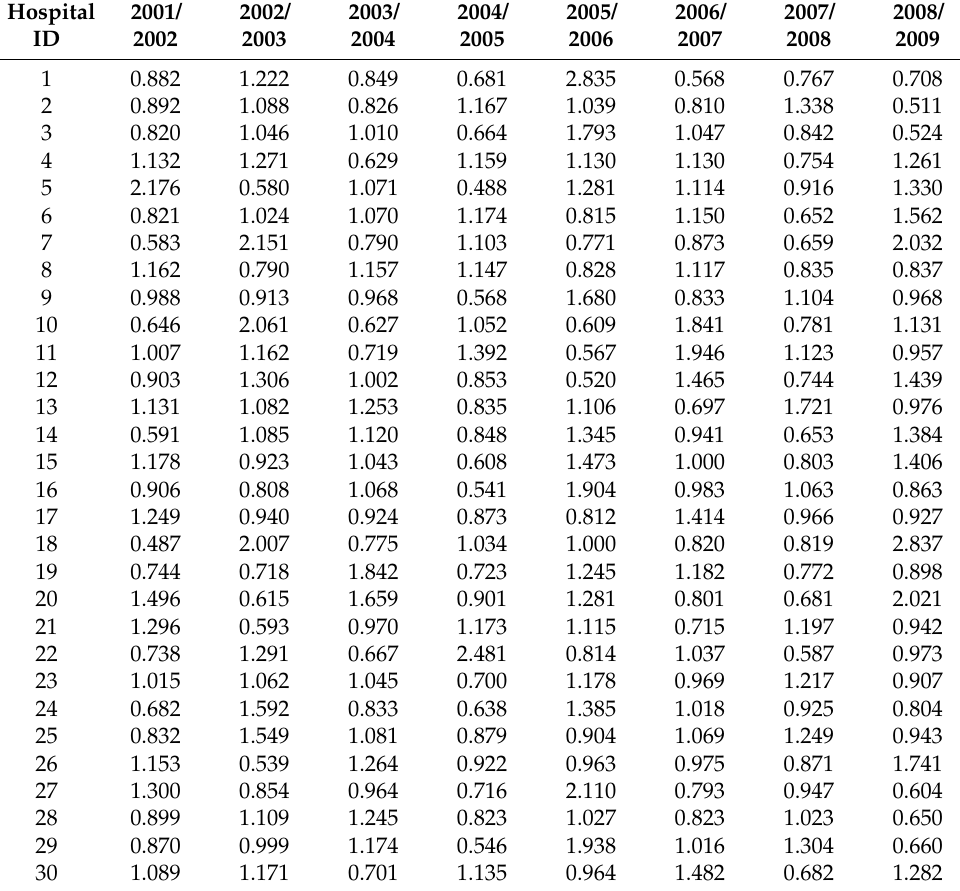
Table A1. Bootstrapped productivity changes of Malmquist indices,